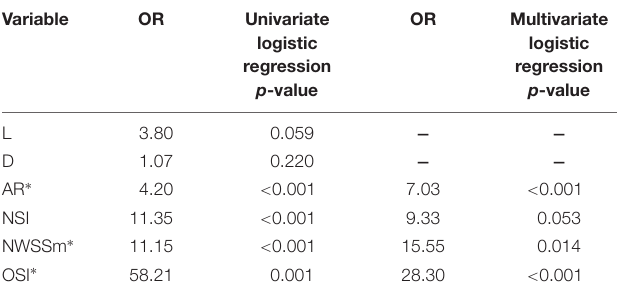
TABLE 3 | The result of logistic regression